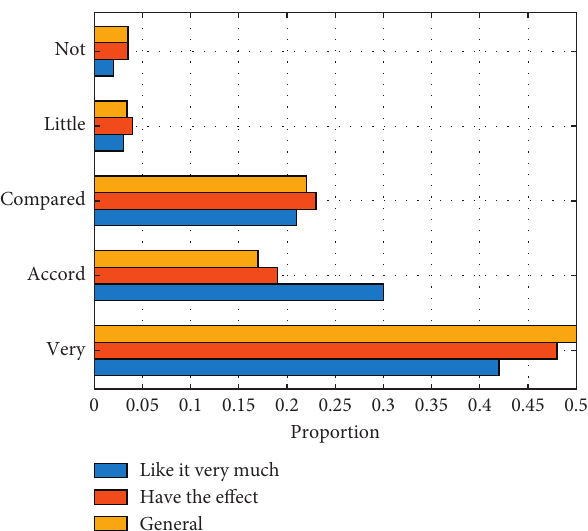
Figure 6: Feedback survey results of English listening audio language